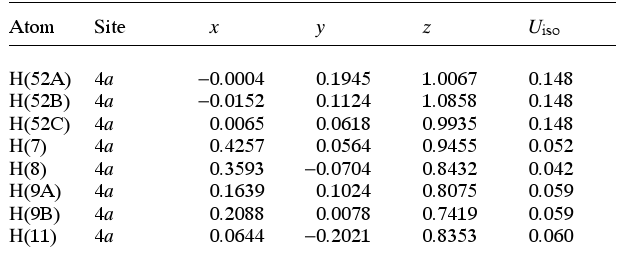
Table 2. C ontinued .